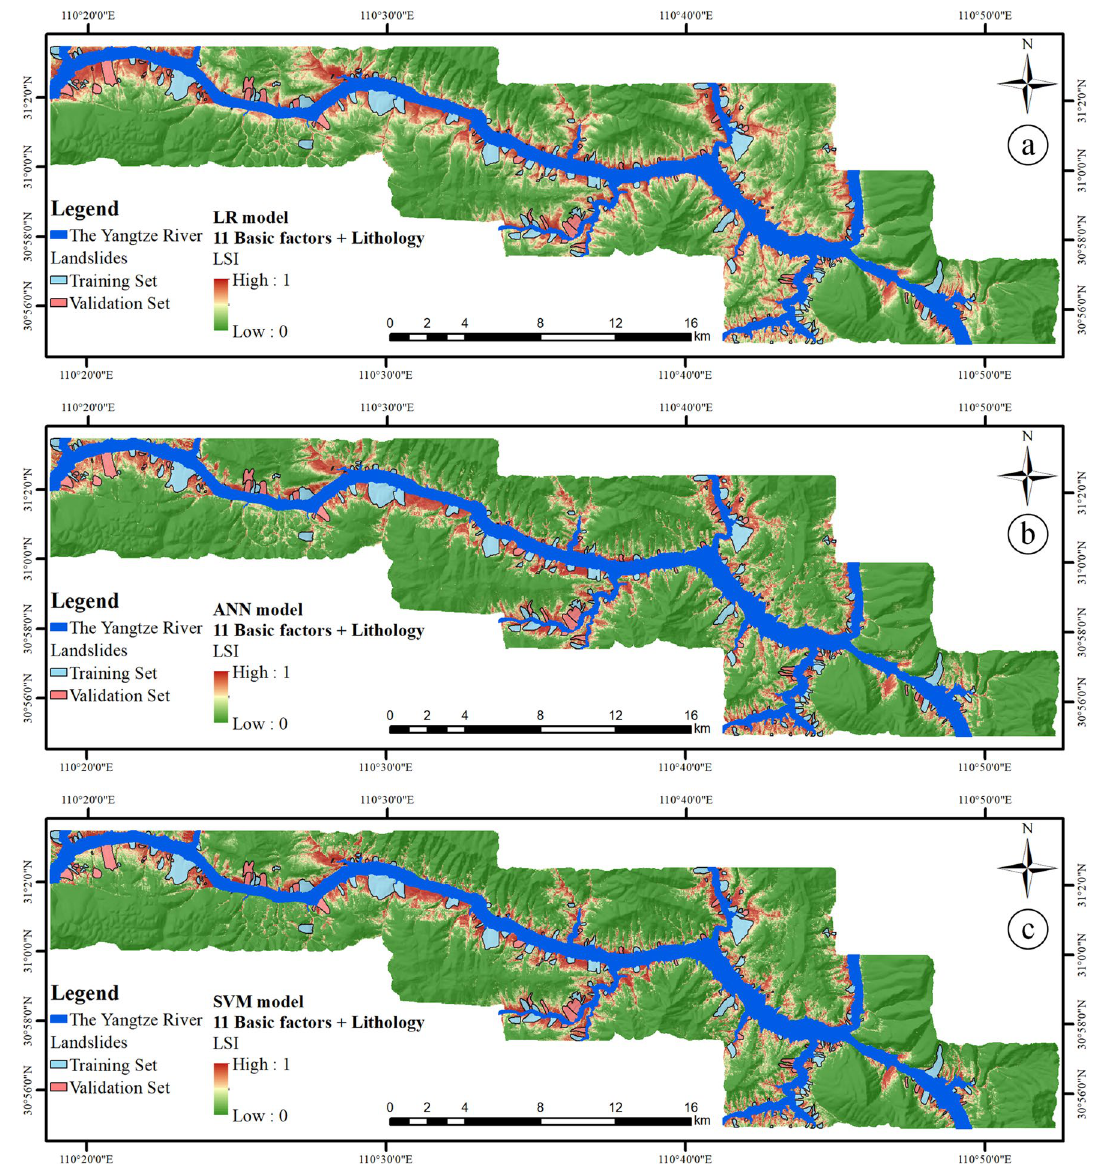
Figure 11. LSI based on the basic factors and lithology factor by ( a ) LR model, ( b ) ANN model, and ( c ) SVM